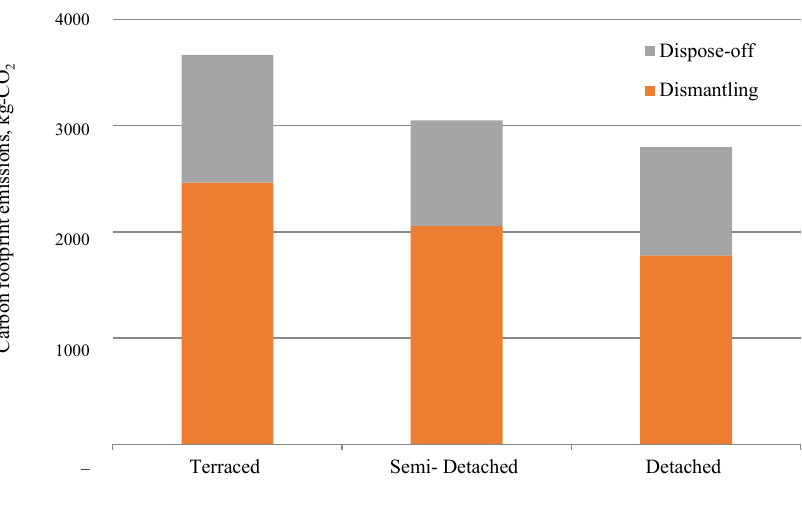
Fig. 5. Total carbon footprint from D &